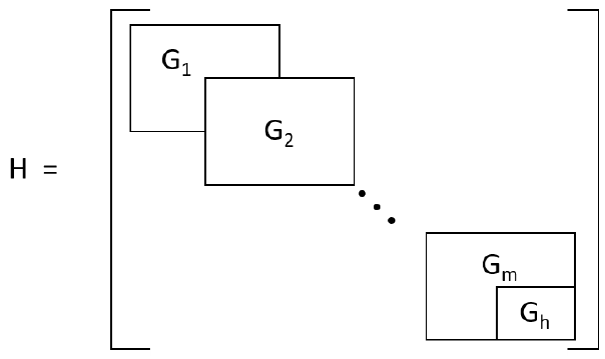
Figure C1. Construction of the global stiffness matrix in which G is the stiffness matrix of a layer, the h represents the number of layers with finite thickness, and the m represents the half-space